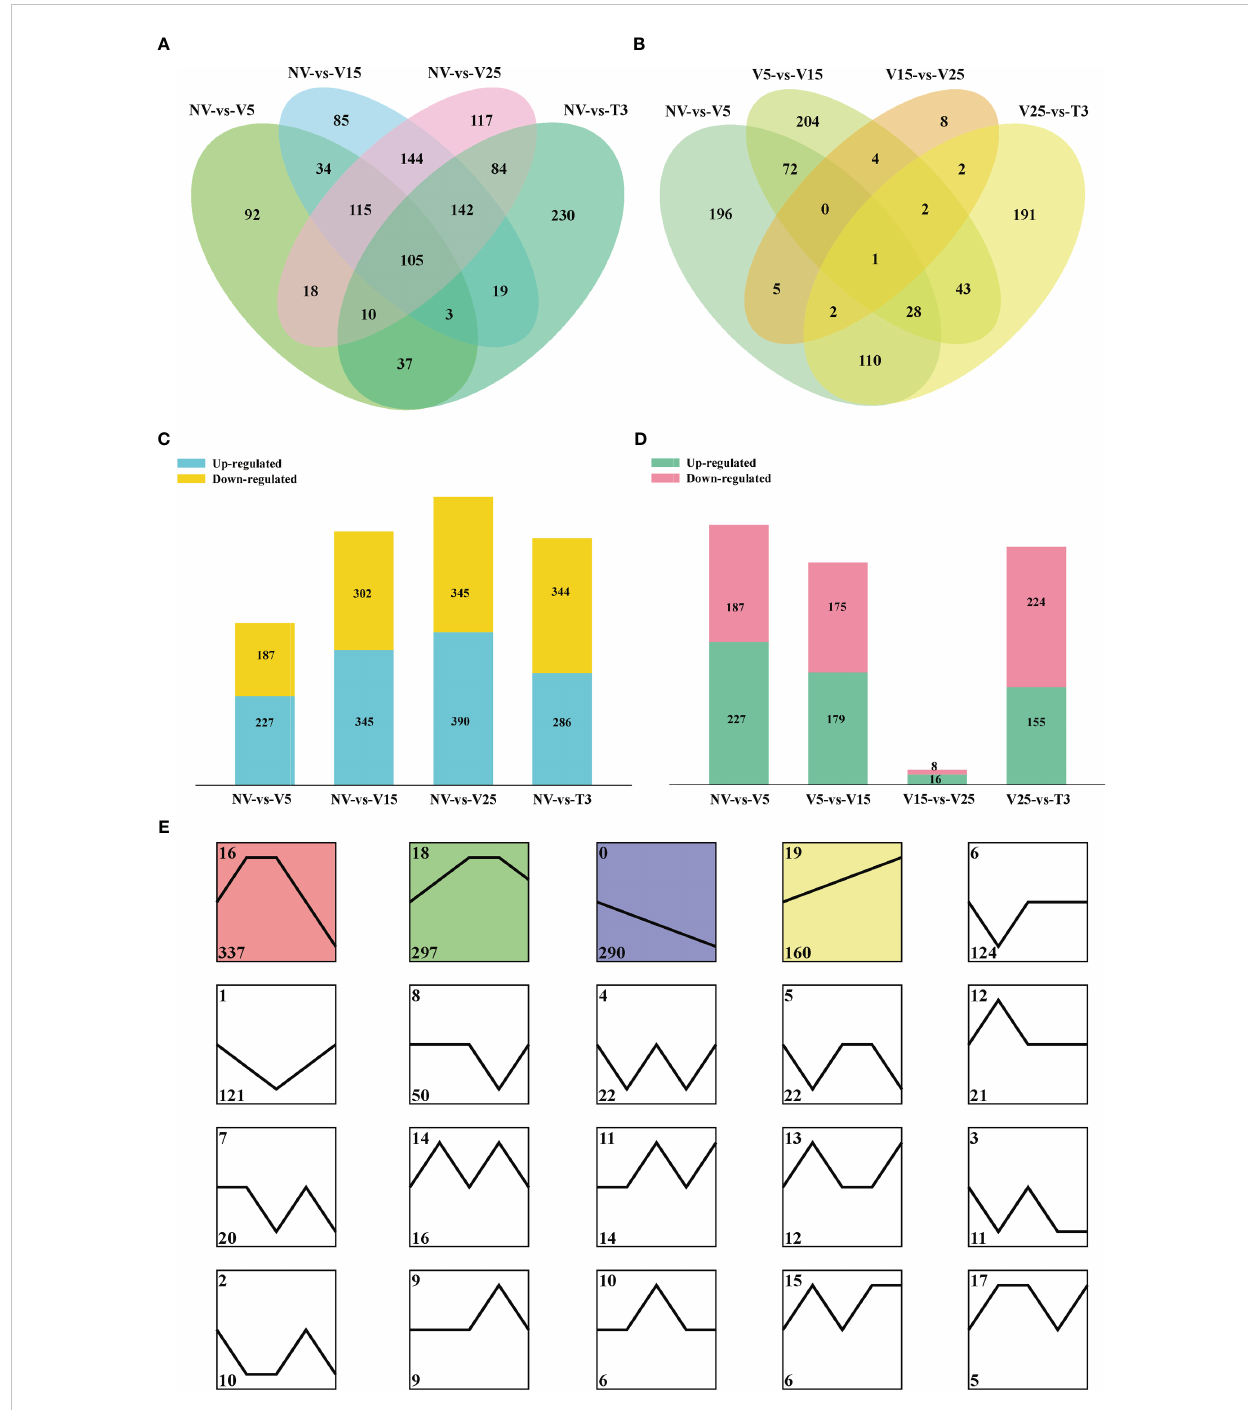
FIGURE 3 Differentially expressed (DE) lncRNA characteristics in different comparison groups. (A, C) The number of DE lncRNAs and their Venn diagrams between NV-vs-V5/V15/V25/T3. (B, D) The number of DE lncRNAs and their Venn diagrams between NV-vs-V5, V5-vs-V15, V15-vs-V25, and V25-vs- T3. (E) The expression patterns of DE lncRNAs were identi fi ed by STEM clustering. The square represents an expression mode, the black lines represent the model expression mode, the number in the upper left corner represents the cluster ID, and the number in the lower left corner represents the number of lncRNAs enriched in the